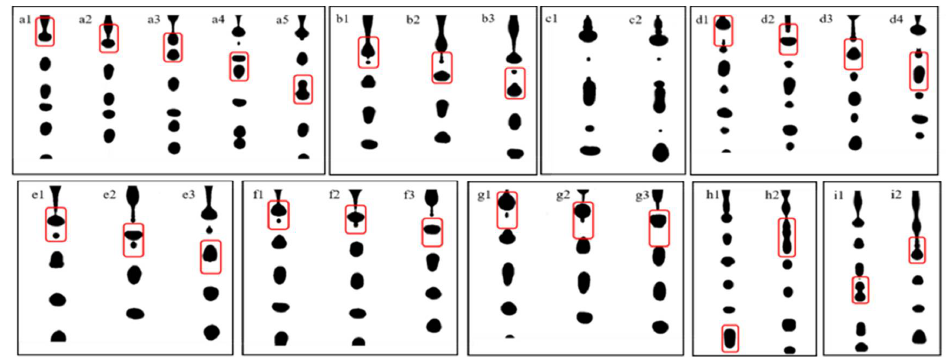
Figure 6. Snapshots of droplet generation at the volume flow rate of 30 mL/h at different pulse frequencies (( a1 – a5 ): 5 kHz; ( b1 – b3 ): 10 kHz; ( c1 – c2 ): 15 kHz; ( d1 – d4 ): 20 kHz; ( e1 – e3 ): 25 kHz; ( f1 – f3 ): 30 kHz; ( g1 – g3 ): 35 kHz; ( h1 – h2 ): 40 kHz; ( i1 – i2 ): 45